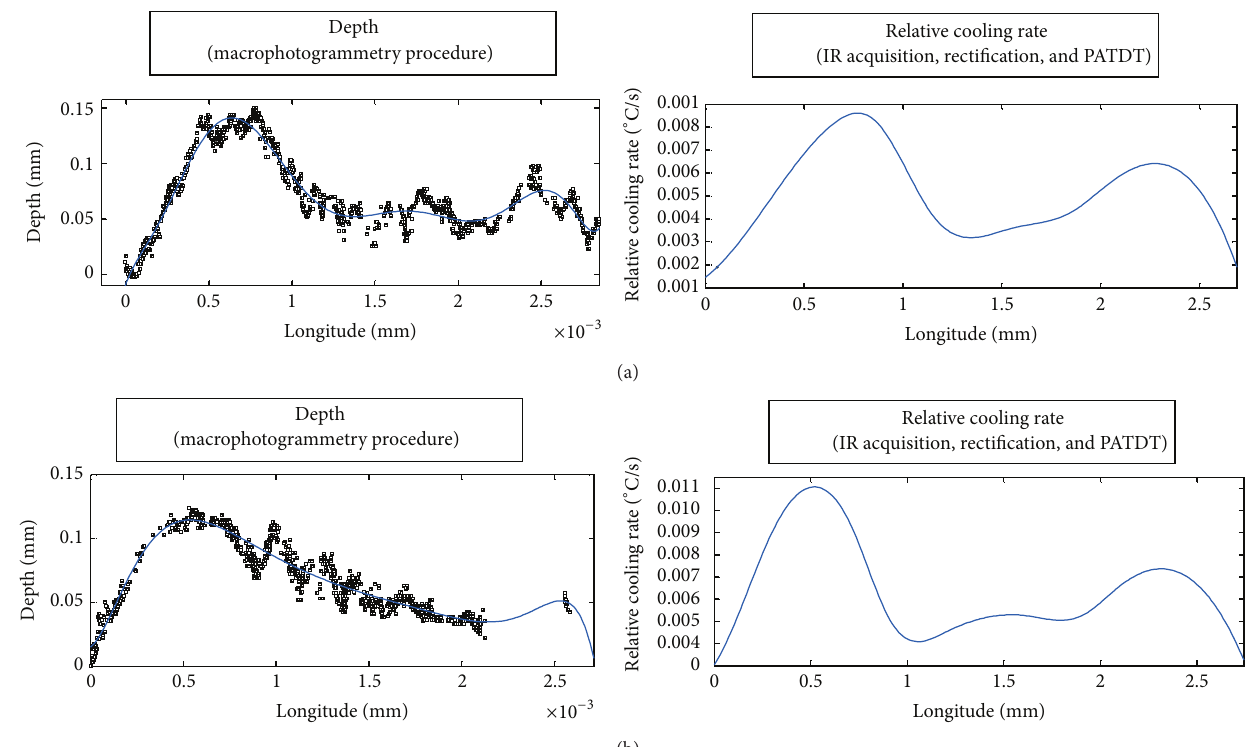
Figure 6: Depth function and relative cooling rate function along the longitudinal sections ( 𝐿1 (a) and 𝐿2 (b)).